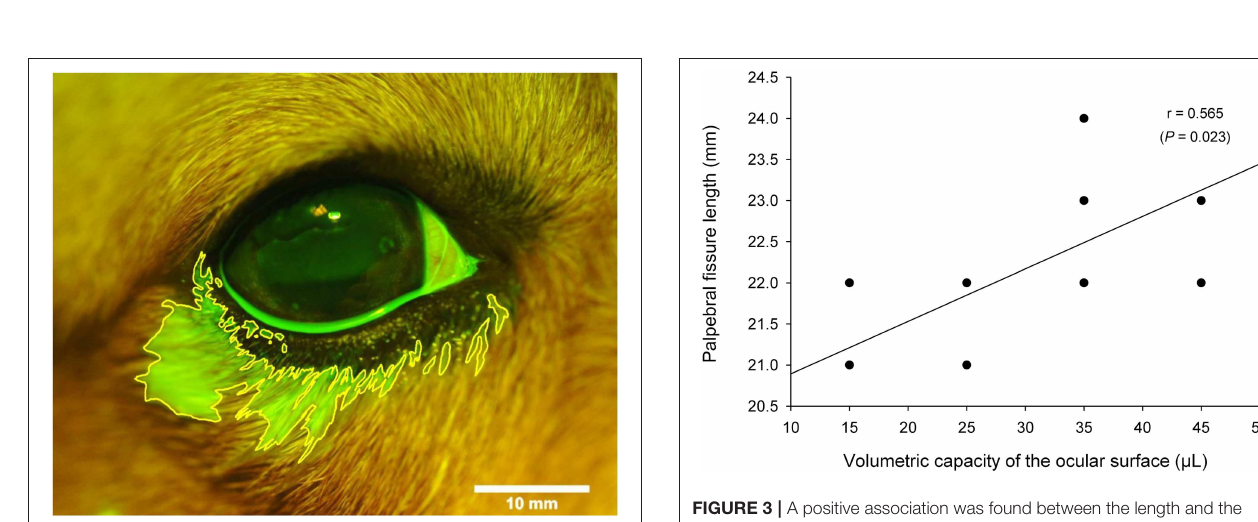
FIGURE 1 | Photographs of the right eye and eyelids in a representative Beagle dog. The volumetric capacity of the palpebral fissure was calculated as 35 µ l in this eye, based on the lack or presence of periocular spillage of 0.1% fluorescein with instillation of either 30 µ l (A) or 40 µ l (B) , respectively.